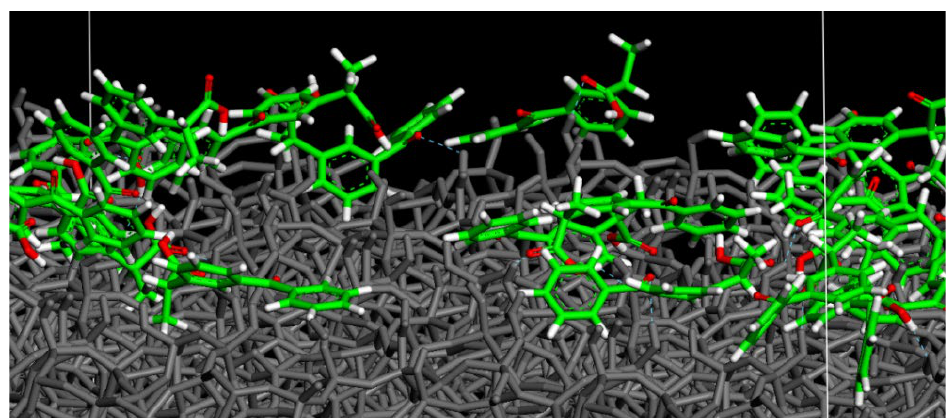
Figure 8. Particular of the optimized geometry of 28 ketoprofen drug molecules in a racemic mixture adsorbed on a dry amorphous SiO 2 surface, without water molecules, after 2 ns in vacuo and energy minimization. In particular the Figure shows the side view of ketoprofen molecules interacting with SiO 2 surface forming H-bonds. Color code: all surface atoms are in grey, ketoprofen carbon atoms are in green, oxygens in red and hydrogen atoms in white. H-bond with the SiO 2 surface is reported in dashed blue lines.